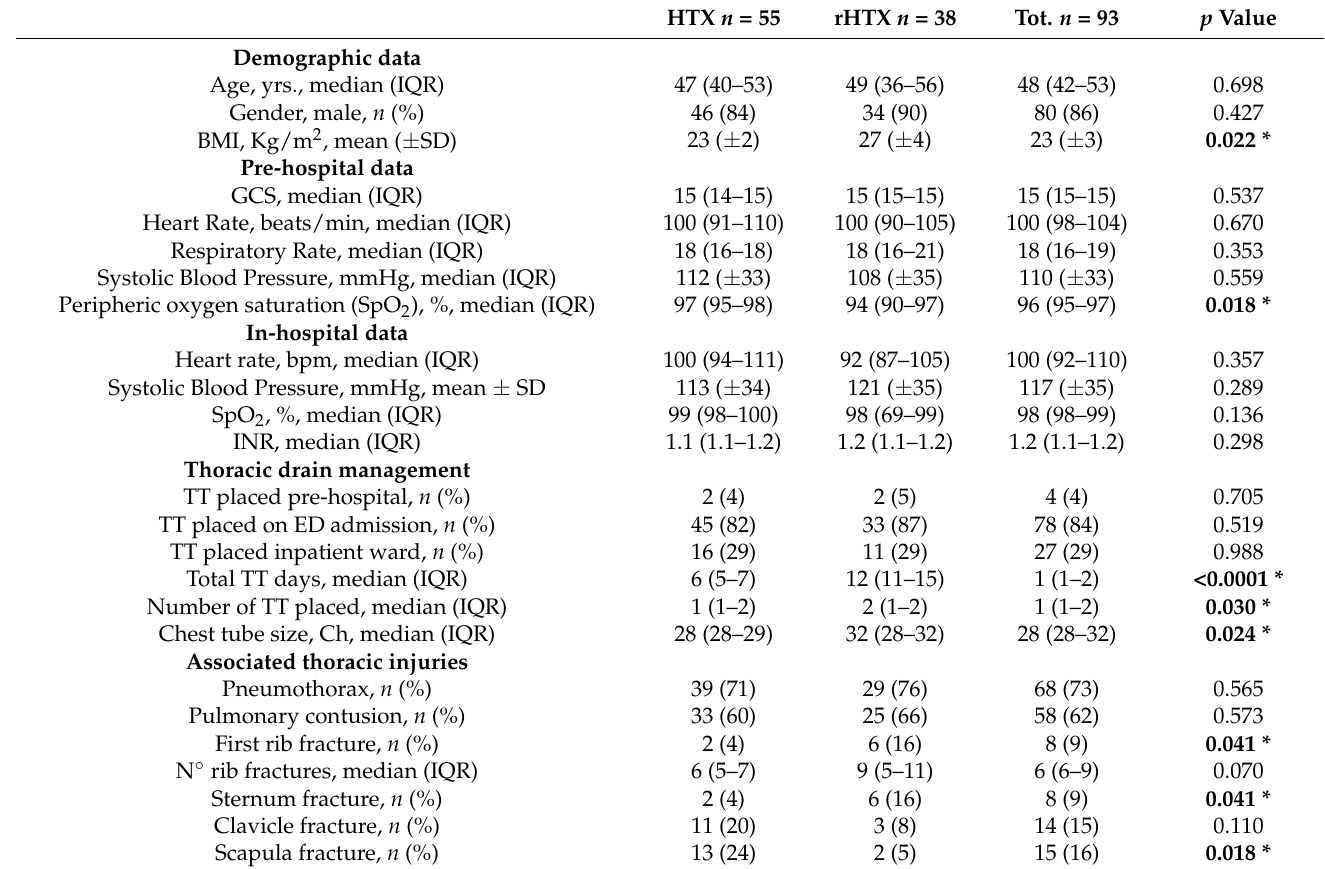
Table 1. Demographic data and univariate analysis of predictive factor for RH. TT: thoracic tube. HTX n = 55 rHTX n = 38 Tot. n =